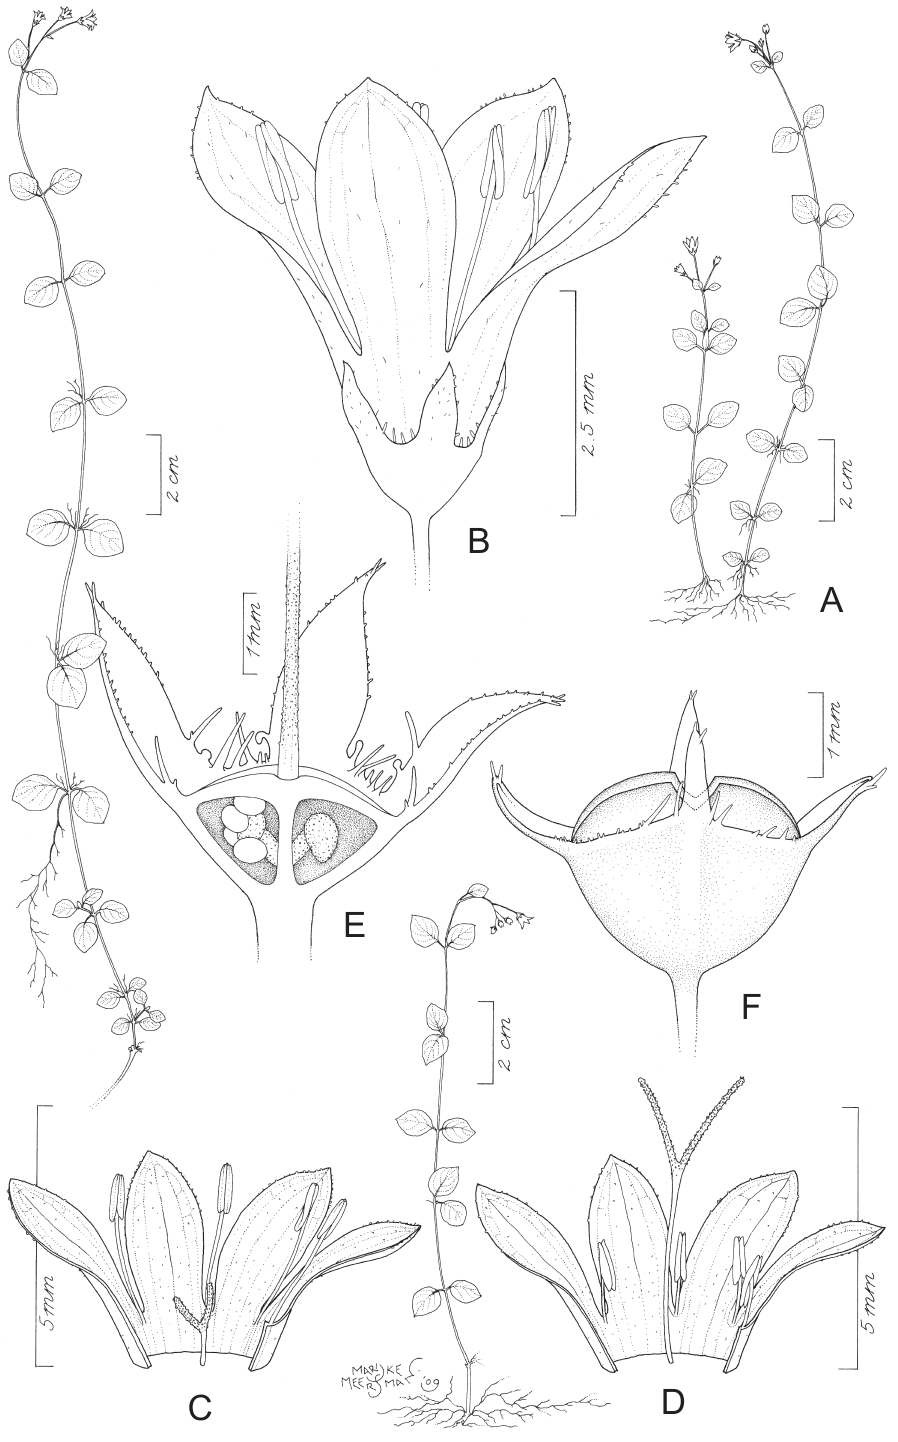
Fig. 14. Astiella perrieri Groeninckx sp. nov. A . Habit. B . Brevistylous flower. C . Open brevistylous flower. D . Open longistylous flower. E . Ovary dissected to show placentation; all ovules removed from the right locule to show the placenta. F . Capsule. Drawn by Marijke Meersman. A–C, E from De Block, Tosh & Rakotonasolo 1927 (BR); D from Perrier de la Bâthie 3958 (P); F from Perrier de la Bâthie 14472